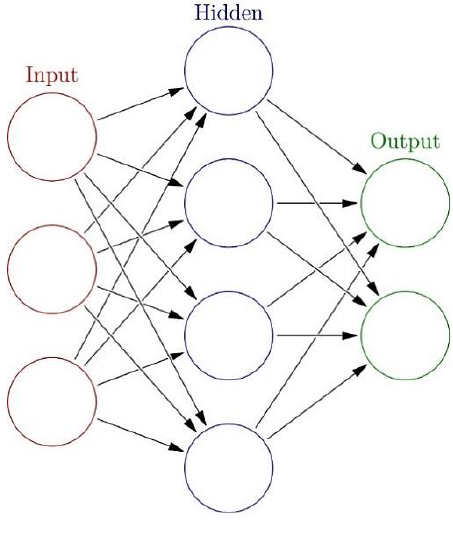
Fig. 4. Structure of the two-layer MLP neural network with a hidden